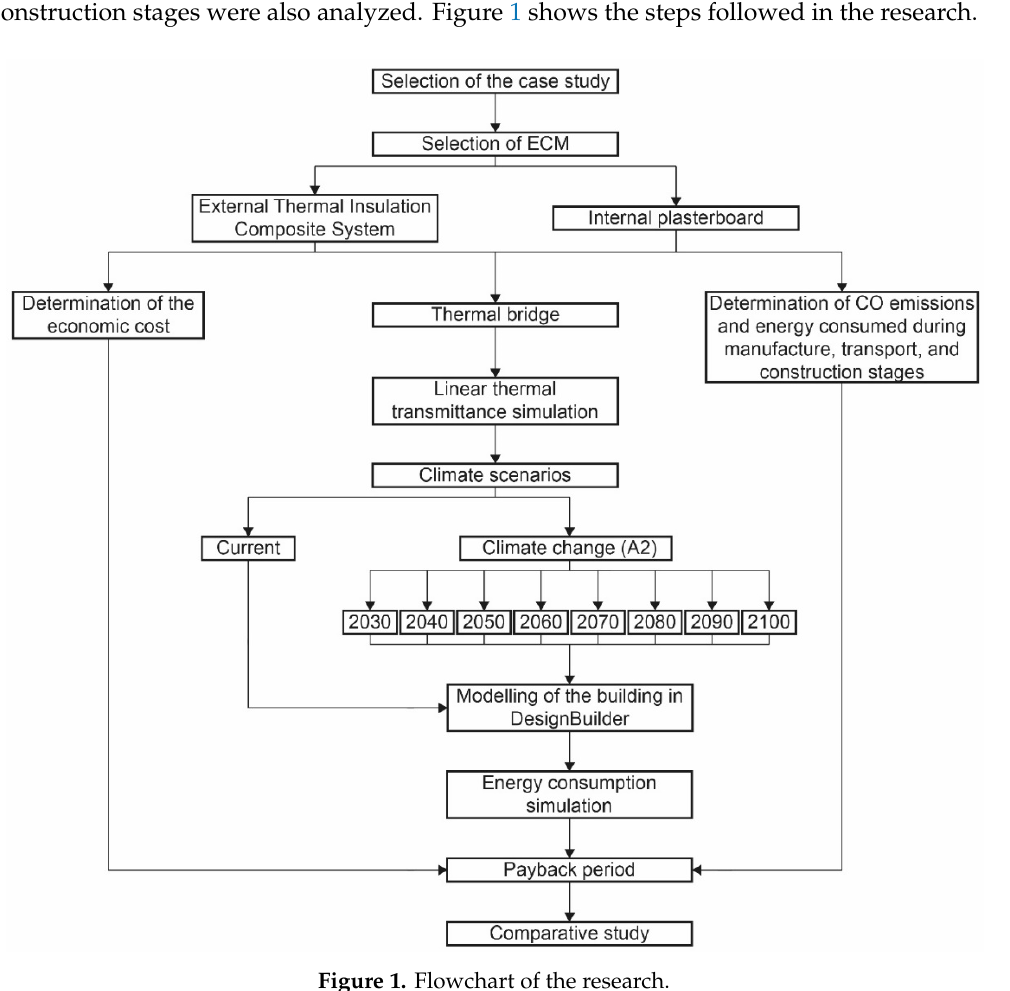
Figure 1. Flowchart of the research.